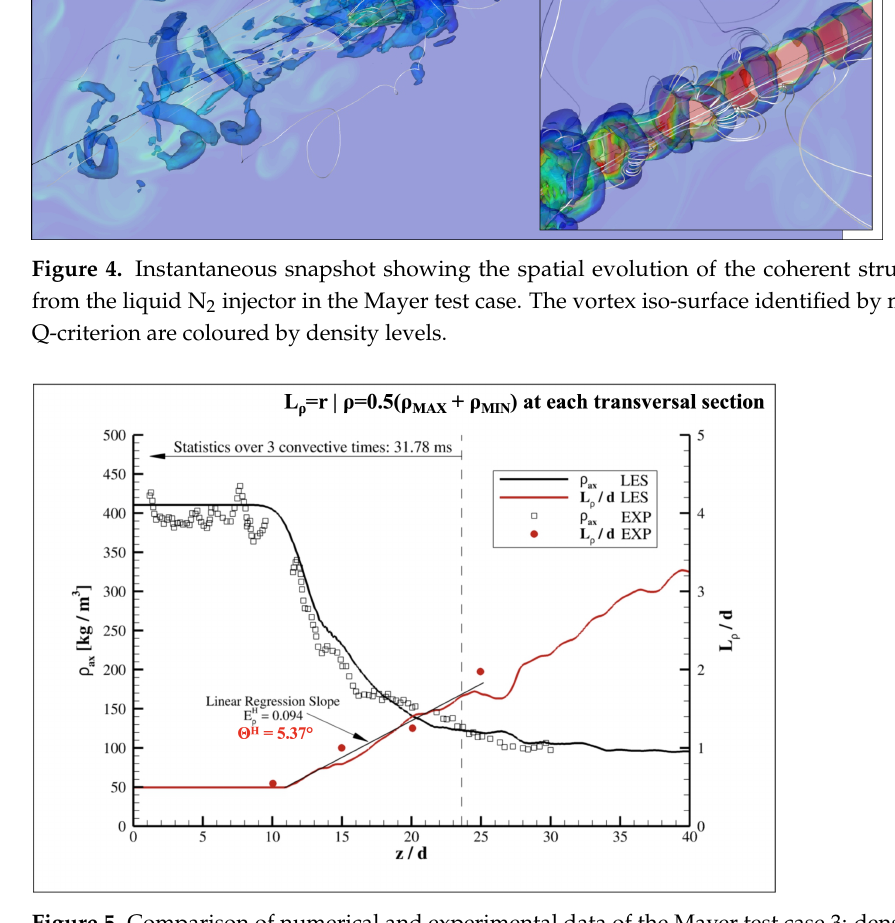
Figure 5. Comparison of numerical and experimental data of the Mayer test case 3: density distribu- tion along the axis of the mixing chamber and liquid nitrogen jet spreading